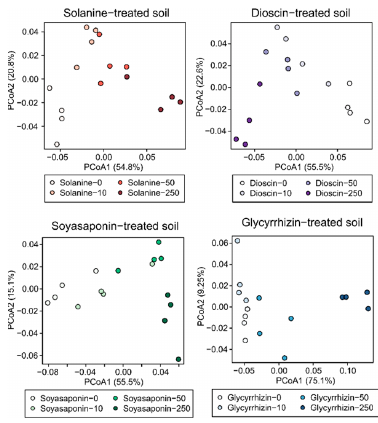
Figure 3. Weighted UniFrac-based principal coordinate analysis (PCoA) of the bacterial communities in the soils treated with saponins, 10, 50, and 250 nmol (low, middle, and high concentrations) g soil − 1 . Each saponin − 0 indicates untreated soils.